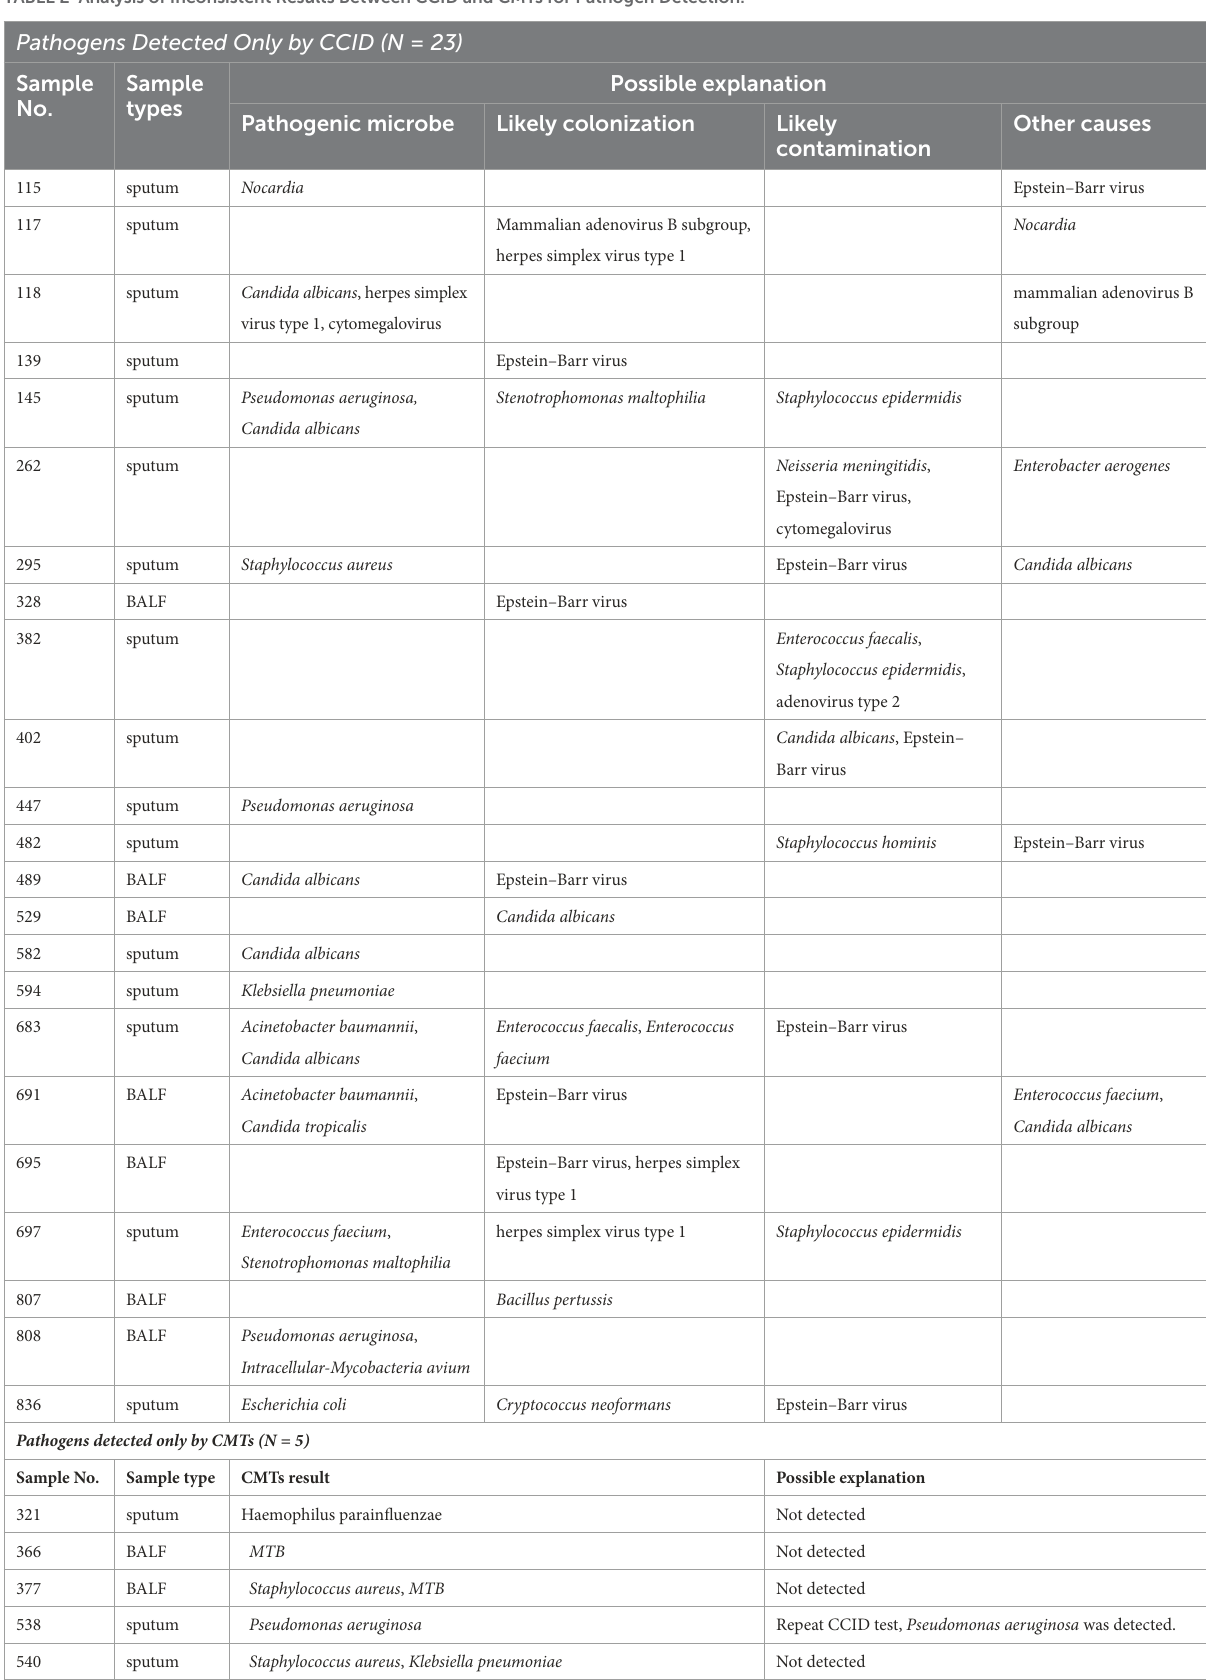
CCID, Chips for Complicated Infection Detection; CMTs, Conventional Microbiological Tests; BALF, Bronchoalveolar Lavage Fluid; MTB, Mycobacterium